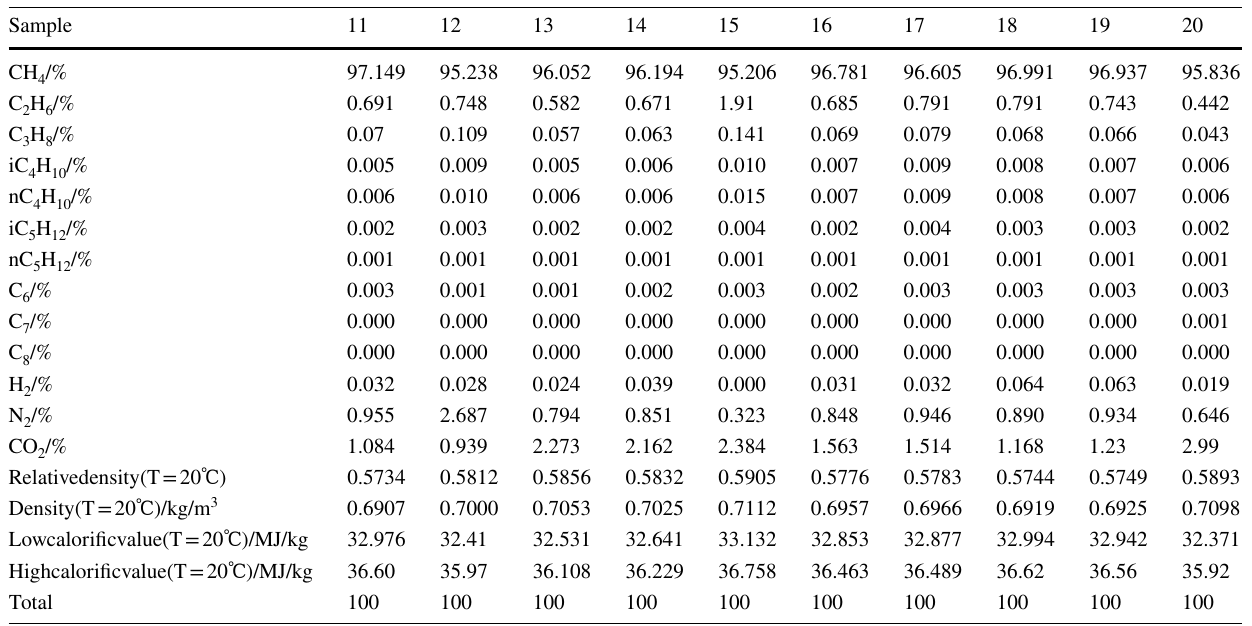
Table 3 Composition of 30 groups of natural gas